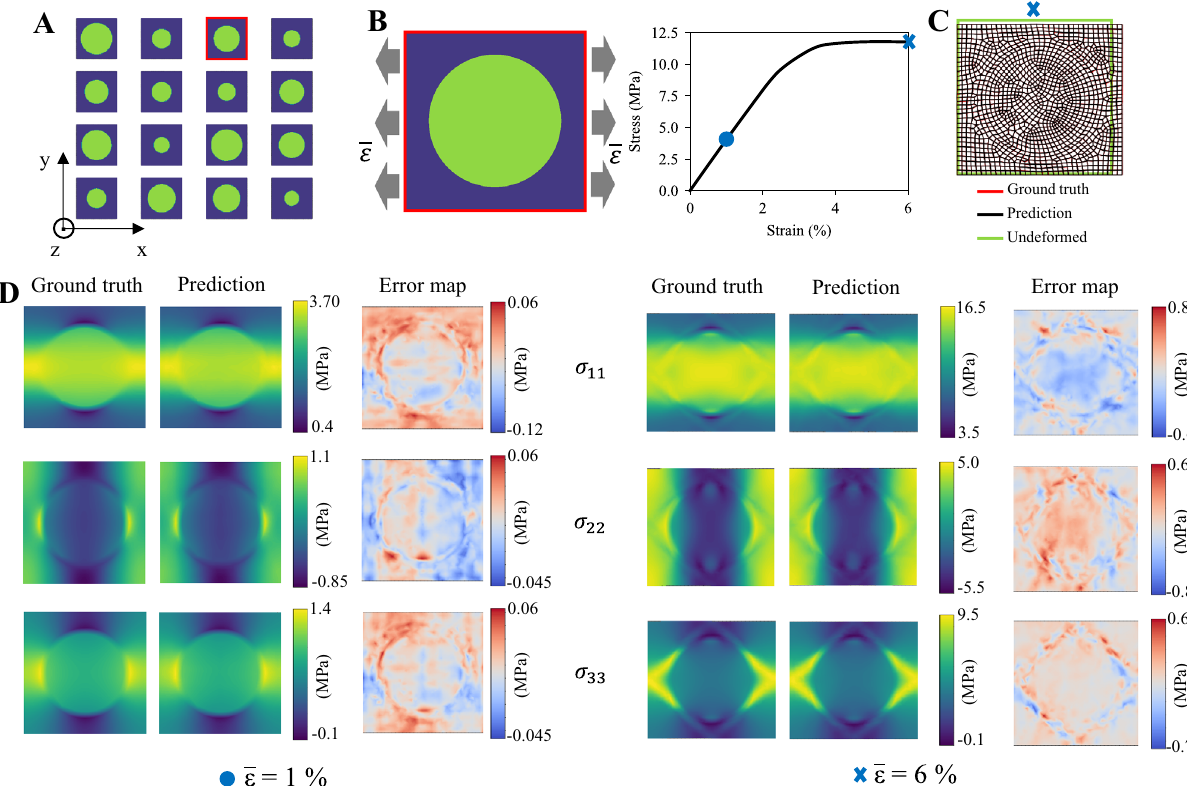
Figure 2. Predicting elasticity and plasticity in transversally loaded unidirectional fiber composites. ( A ) Examples of RVEs from the dataset having different fiber volume fraction. ( B ) A typical RVE ( f v =37.55 % ) subject to macroscopic uniaxial tension strain ( ε ) together with the corresponding macroscopic stress-strain curve. The symbols in the plot indicate small ( ε =1 % ) and large ( ε =6 % ) deformations, corresponding to linear elasticity and plasticity, respectively. ( C ) Comparison of the FE simulated (i.e., ground truth) and ML predicted deformed mesh for ε =6 % . ( D ) Comparison of the ML predicted and FE simulated stress fields in the RVE shown in ( B ), randomly chosen from the test dataset, for small and large deformations, with the corresponding error map (i.e., difference between prediction and ground truth). The stress fields are plotted over the corresponding deformed shapes (exact relative scale between small and large deformations), while the error maps are shown in the undeformed configuration. Analogous results for the shear stress field ( σ 12 ) are reported in Supplementary